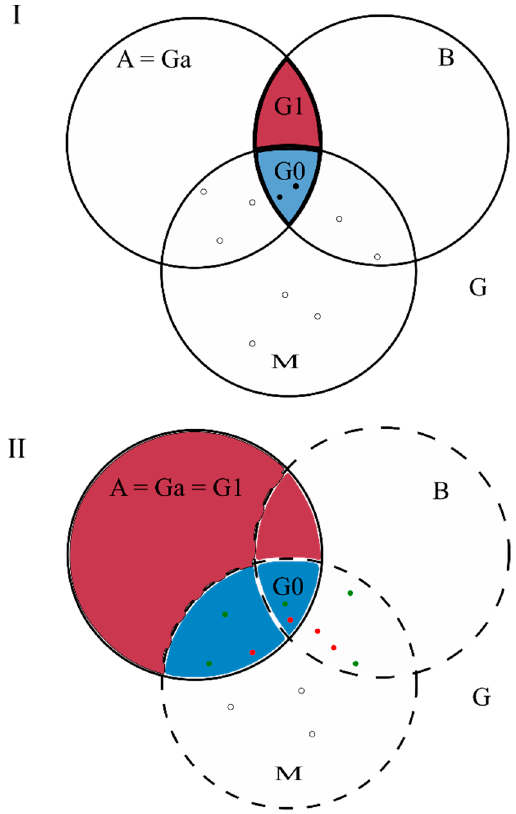
Figure 8. ( I ) Representation of the classical BAM diagram adapted from Peterson (2012). ( II ) Variation of the BAM diagram to represent endophytes and latent pathogens such as Botryosphaeriaceae species. Three factors are suggested to define species geographic distribution: biotic (B), abiotic (A), and movement (M). By interactions among these factors four areas, we can define: G, the geographic space within which analyses are developed; Ga, the abiotically suitable area; G0, the occupied distributional area; G1, the invadable distributional area. Black solid circles indicate species occurrence, red solid circles indicate occurrence in symptomatic hosts, green solid circles indicate occurrence in asymptomatic hosts, and open circles indicate